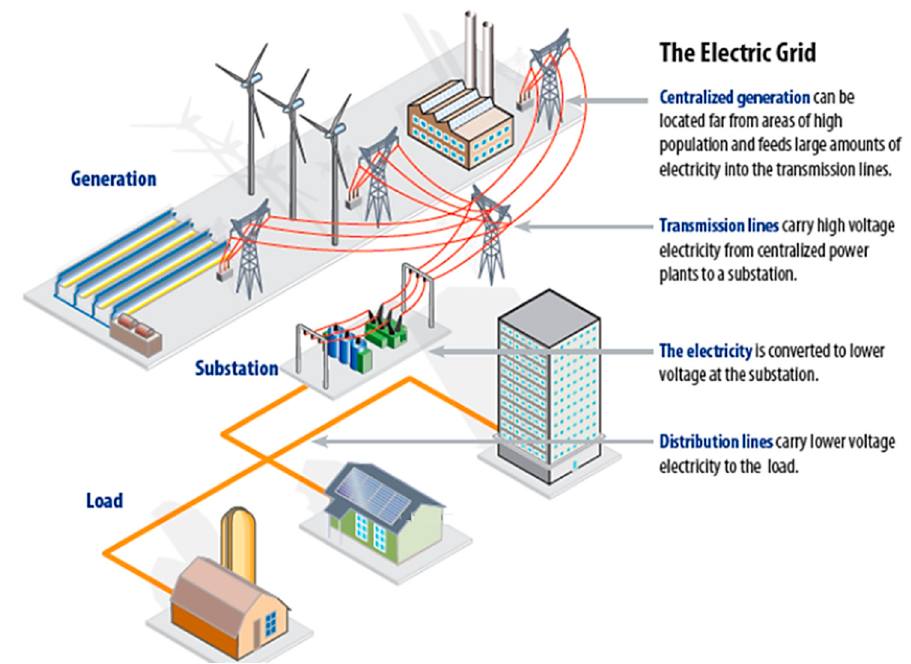
Figure 1. General flow of transmission and distribution network for electric power supply.